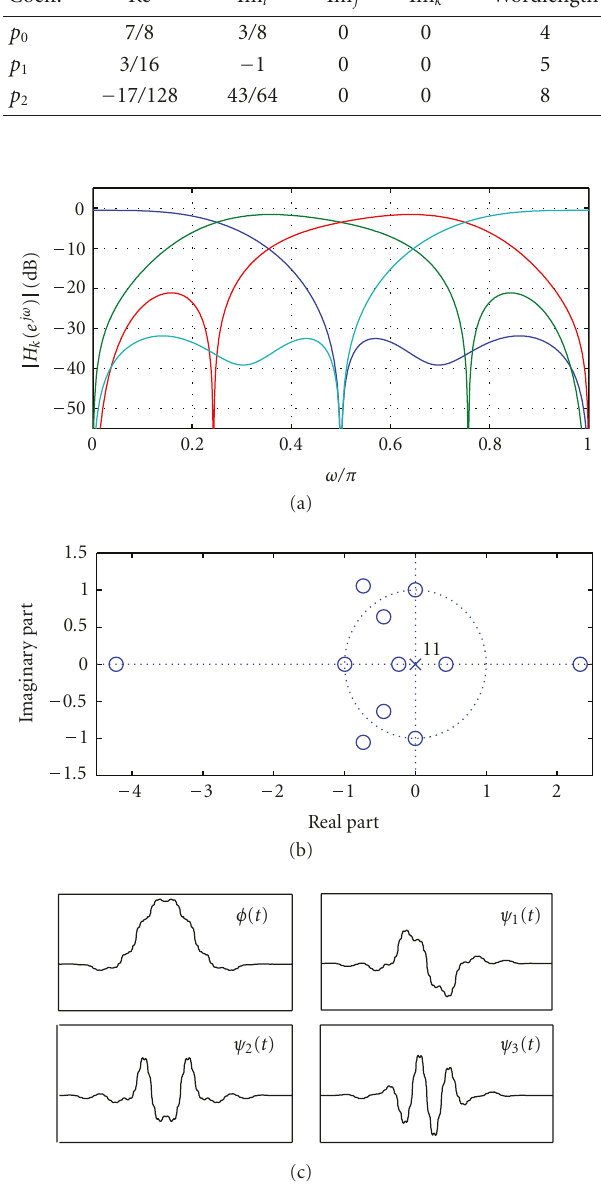
Figure 12: Design example of PMI LP PUFB: (a) magnitude re- sponses, (b) zeros of H 0 ( z ), and (c) the scaling function and